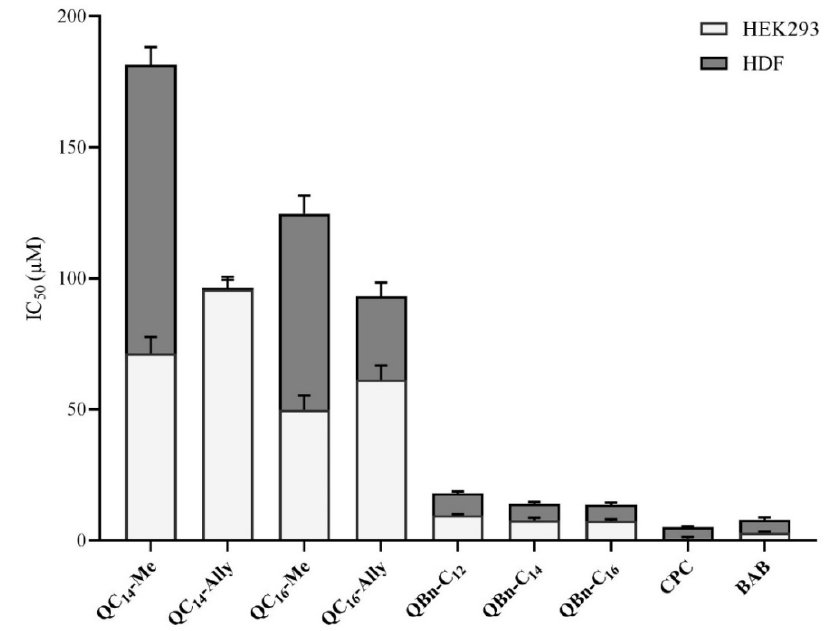
Figure 5. Cytotoxicity of 3-amidoquinuclidine quaternary ammonium compounds (QACs) and commercial QACs, cetylpiridinium chloride (CPC), and benzyldodecyldimethylammonium bromide (BAB). The IC 50 values obtained are given as bars in µ M values.